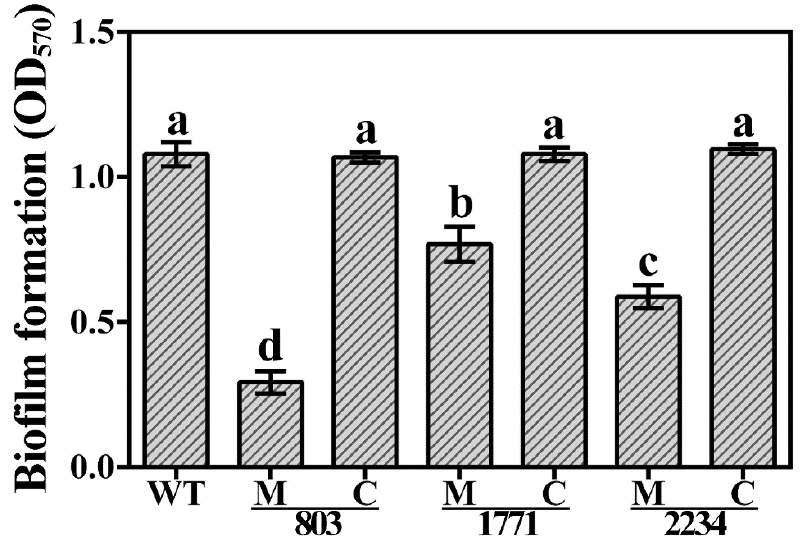
Figure 10. Biofilm formation of the three knockout mutants and corresponding complemented strains of Xanthomonas oryzae pv. oryzae strain C2. WT: Wild type; M: Knockout mutant; C: Complemented strains. Data of optical density at 570 nm (OD570) were presented as means ± standard errors ( n = 3). Columns with different letters (a–d) are significantly different according to LSD test ( p = 0.05).